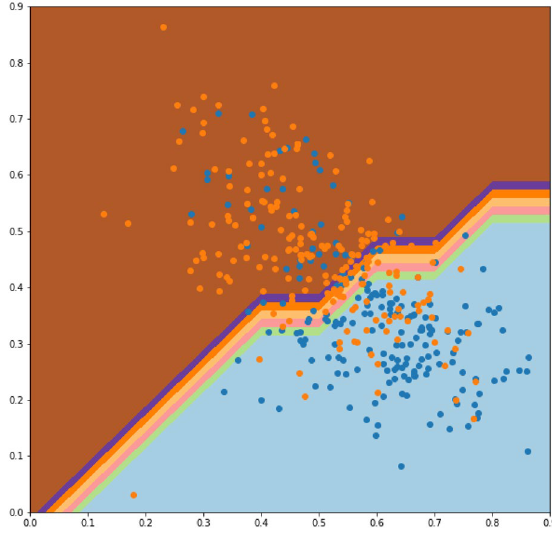
Figure 6. The feature visualization scatter plot of features extracted and used in the proposed